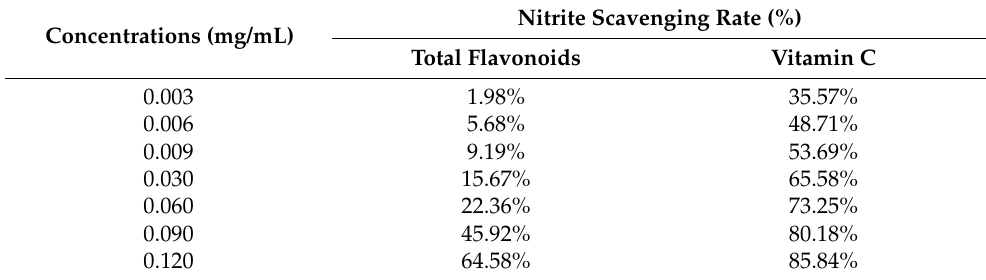
Table A4. The capacity of scavenging nitrite with total flavonoids from perilla